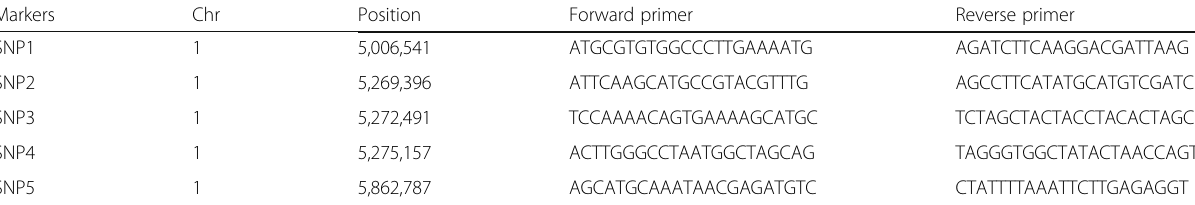
Position refers to the physical location of